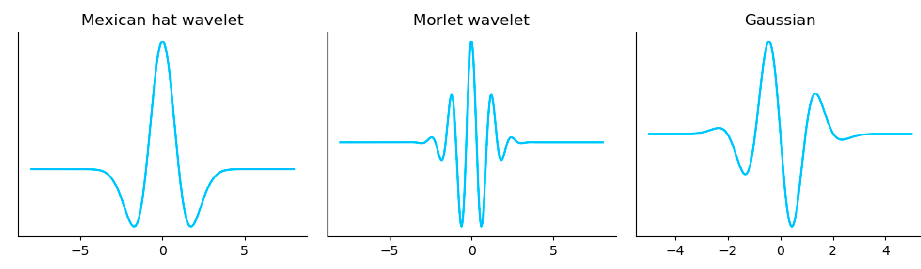
Figure 2. Types of continuous wavelets.